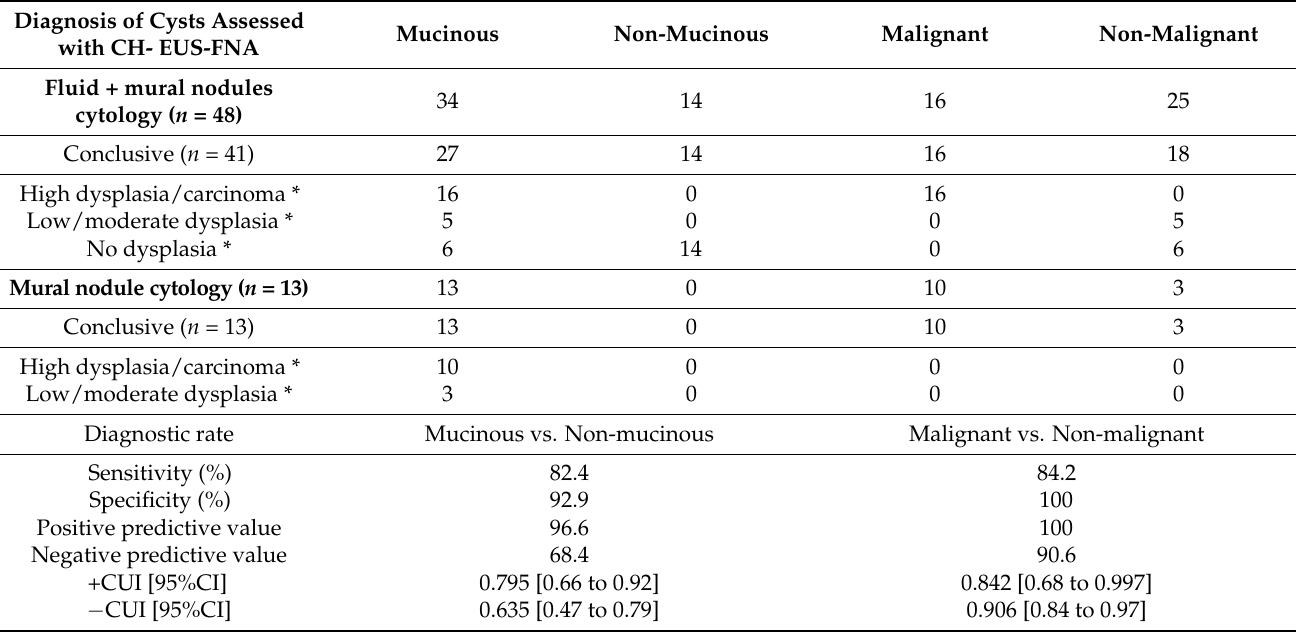
Table 4. Contrast-EUS-FNA cytology assessment of pancreatic